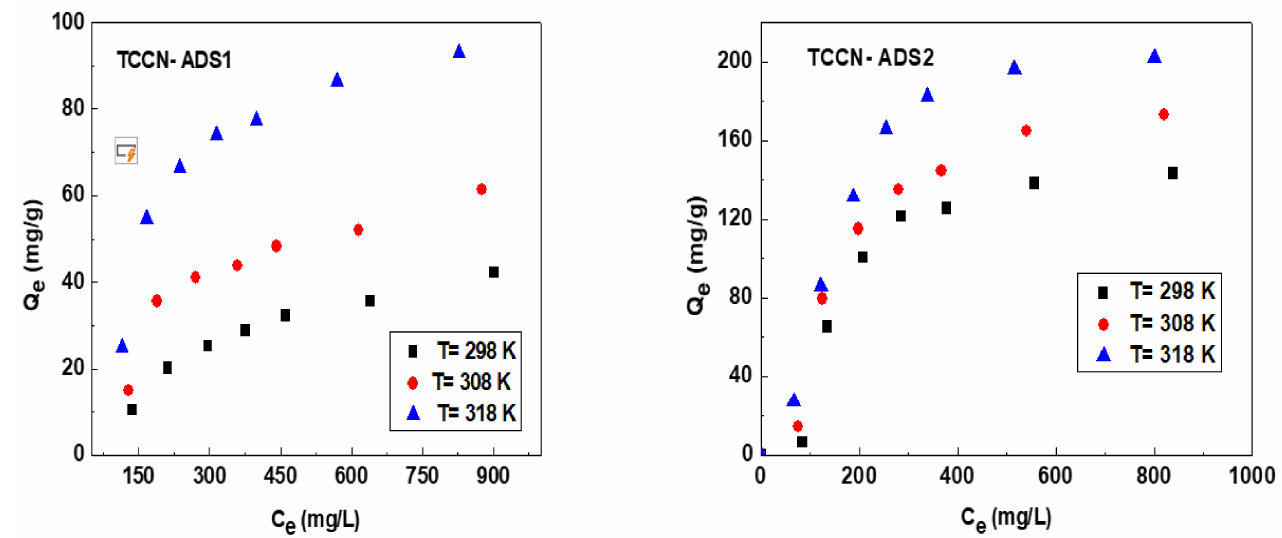
Figure 1. Adsorption data of TCCN on ADS1 and ADS2 at different